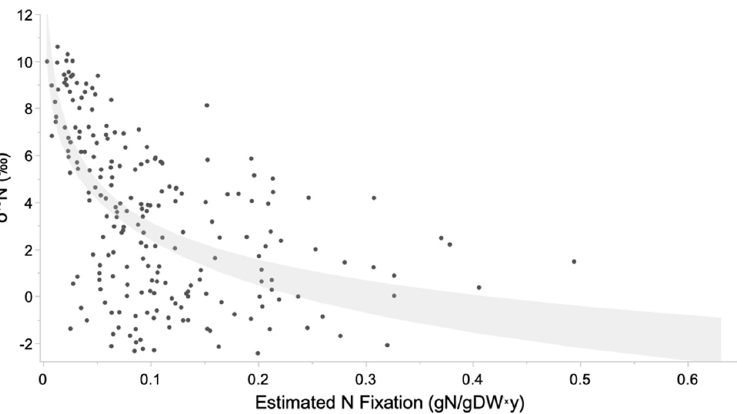
Figure 5. Relationship between N-fixation rates as estimated by acetylene reduction assay and the δ 15 N of plants at the terminus of the experiment, with a log-linear confidence of fit between the two methods depicted in light gray.